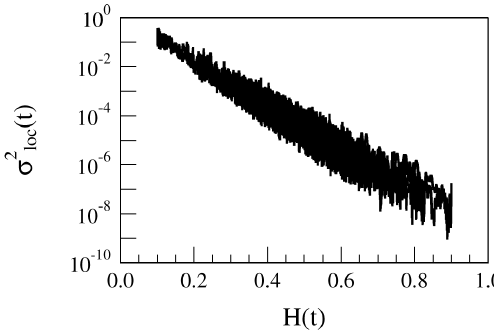
Fig. 3. Plot of the local variance σ 2 loc ( t ) versus the local Hurst/H¨older exponent H ( t )